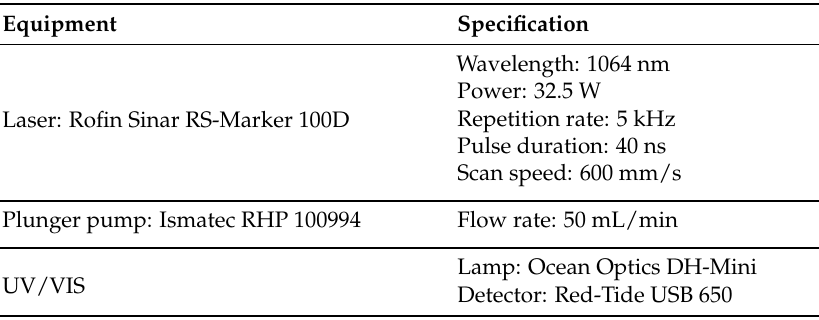
Table 1. Equipment of PLAL test